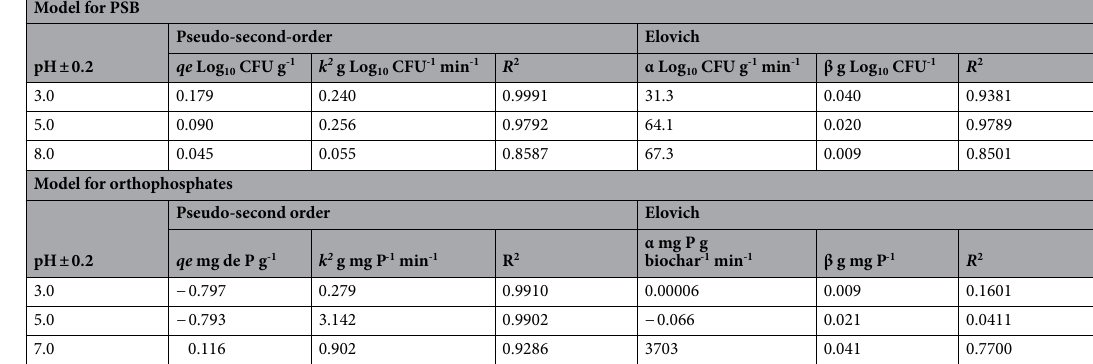
Table 3. Values for the constants of the kinetic models used to fit the experimental data on the adsorption of PSB and orthophosphates on BC prepared at 500 °C 1 h. Where qe is the amount of PSB or orthophosphates adsorbed at time t (PSB: Log 10 UFC g -1 ) and (orthophosphates: mg g -1 ), k 2 is the equilibrium rate constant of pseudo-second-order adsorption (PSB: g Log 10 UFC -1 min -1 ) and (orthophosphates: g mg P -1 min -1 ), α is the initial adsorption rate (PSB: Log 10 CFU g -1 min -1 ) and (mg P g biochar -1 min -1 ), β is the desorption constant (PBS: g Log 10 CFU -1 ) and (g mg P -1 ) during any one